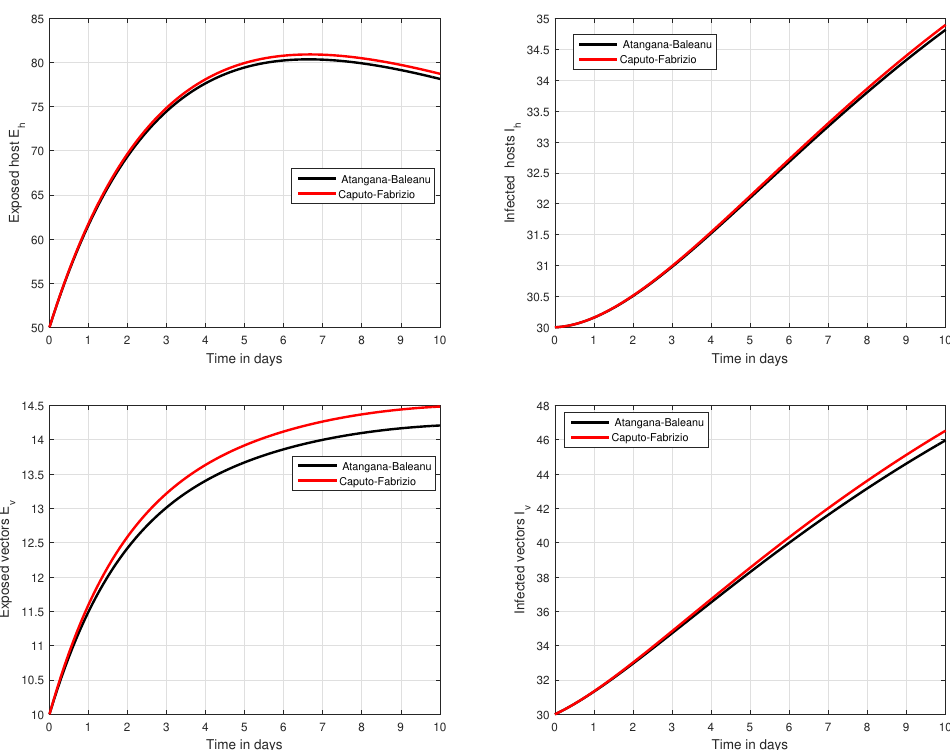
Figure 10. Time series analysis to compare the proposed CF and ABC operator.